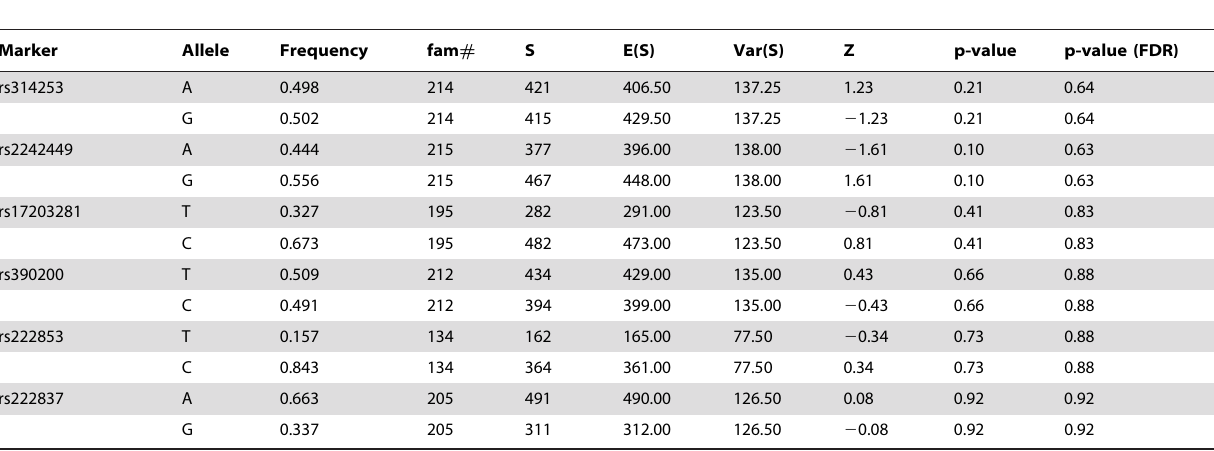
Table 2. FBAT analysis of the DLG4 in Chinese schizophrenia pedigree samples.